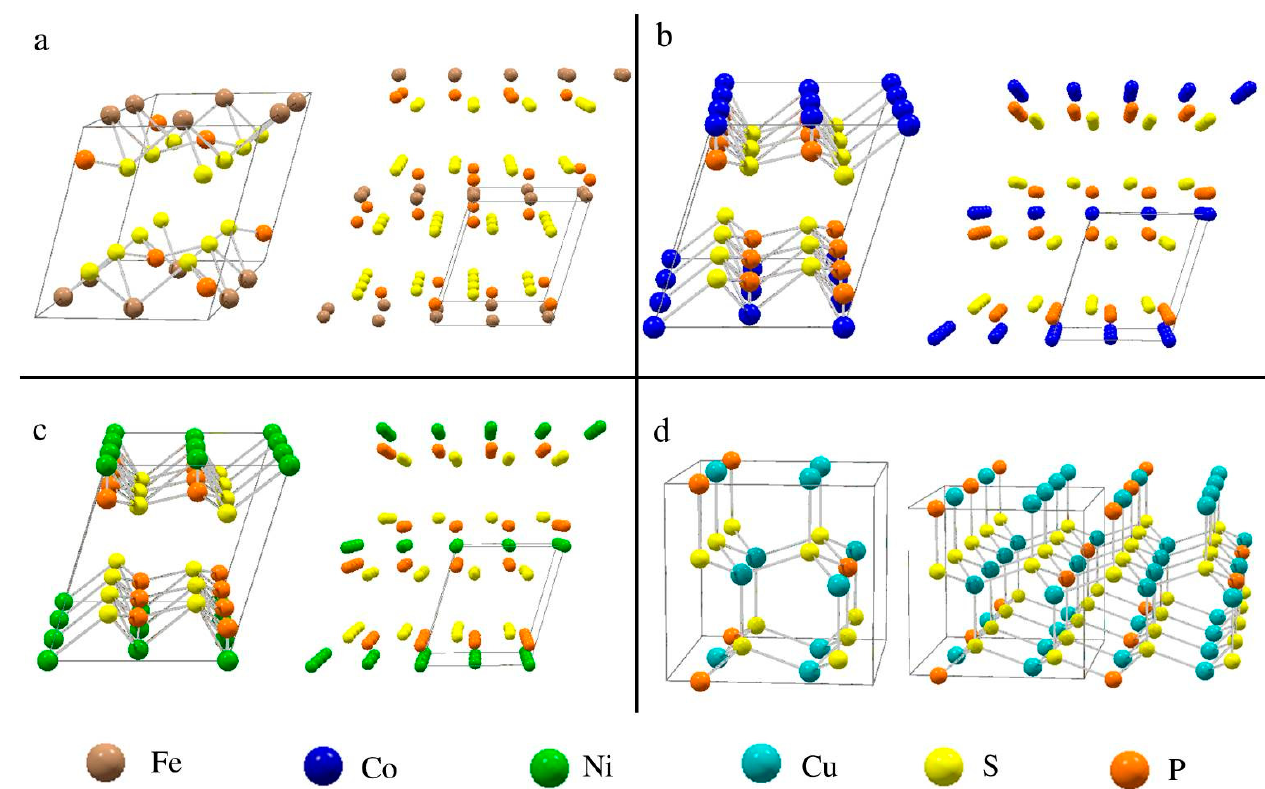
Figure 3. Unit cell and extended structures for the targeted products: ( a ) FePS 3 , ( b ) CoPS 3 , ( c ) NiPS 3 , and ( d ) Cu 3 PS 4 . Extended structures show multiple unit cells.